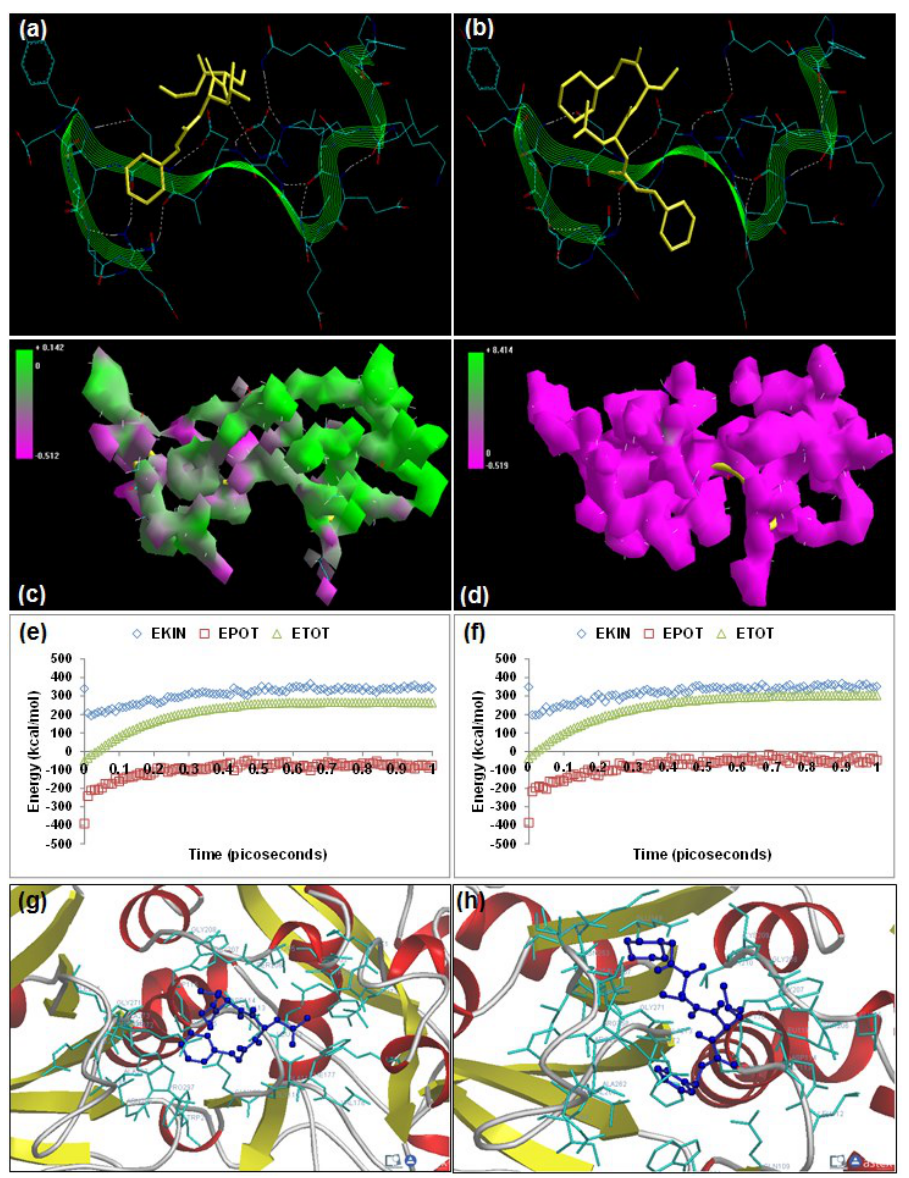
Figure 3. Visualization of the geometrical preferences of the calpain molecule (green secondary structure) in complexation with ligand molecules (yellow tube rendering). ( a ) AK275 and ( b ) AK295 after molecular mechanics simulations. 3D-mapped